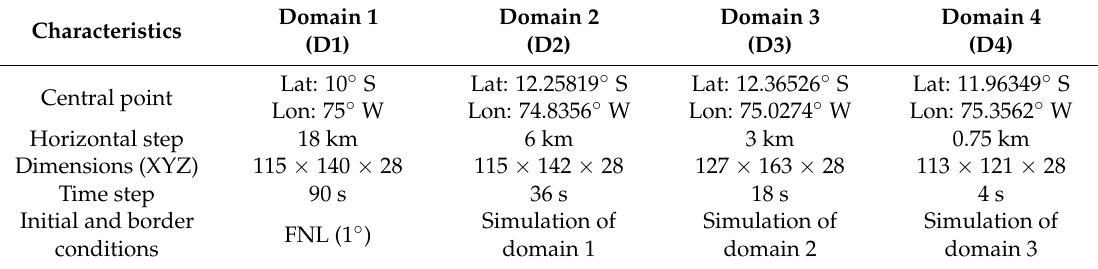
Figure 2. Model domains used in the simulations. Terrain elevation is indicated with color shades in meters above sea level. In the 3 largest domains, the black contour indicates the limits of the Mantaro Basin. In D4, black contour indicates Mantaro Valley. Table 2. Main characteristics of the domains and initial and boundary